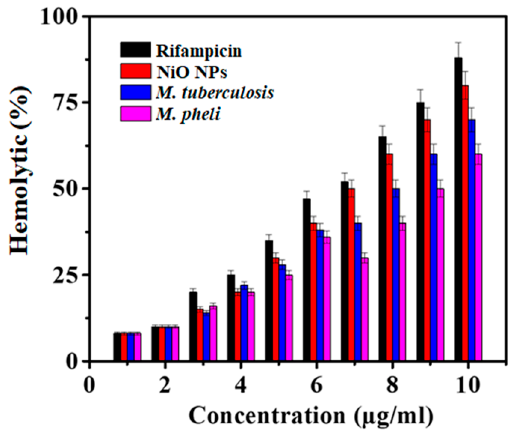
Figure 4. Hemolytic activity of NiO NPs as compared to Rifampicin (Mean ± SD; n = 3).